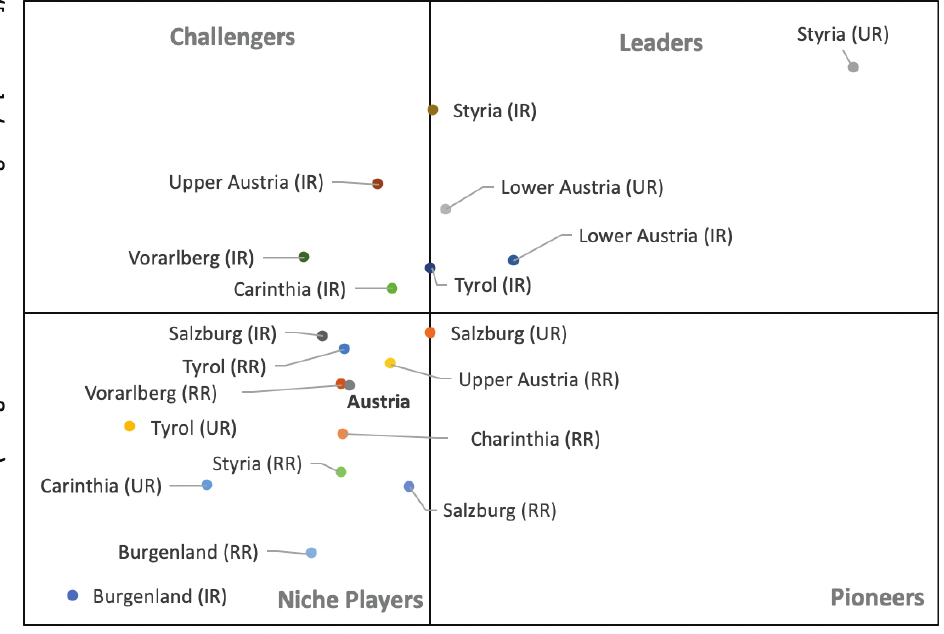
Figure 5: Plot of NUTS3 regions by attractiveness (change in number of overnight stays [Diff. F-O]) and accommodation capacity (change in number of accommodation offers [Diff. F-O]) (own illustration, UR urban region, IR intermediate region and RR rural